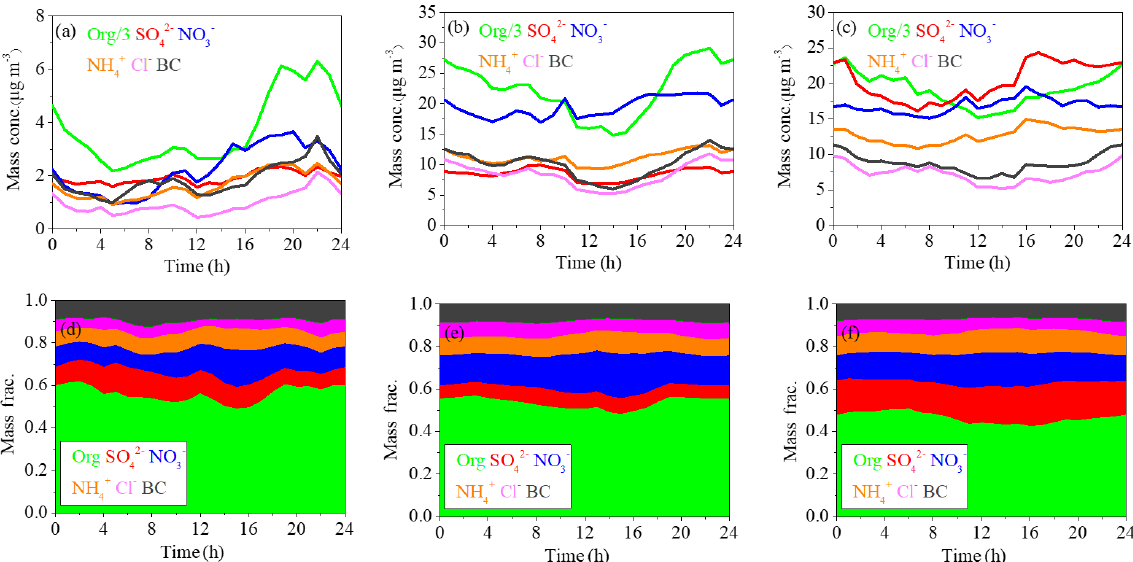
Figure 2. The diurnal variations of mass concentrations and relative contributions of PM 1 components during clean days (a, d) , low-RH pollution days (b, e) and high-RH pollution days (c, f) .